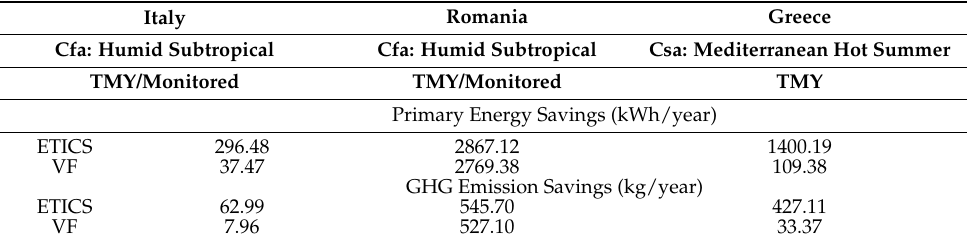
Table 3. Annual savings for Primary Energy and Greenhouse gas emissions with InnoWEE passive solutions for all demo